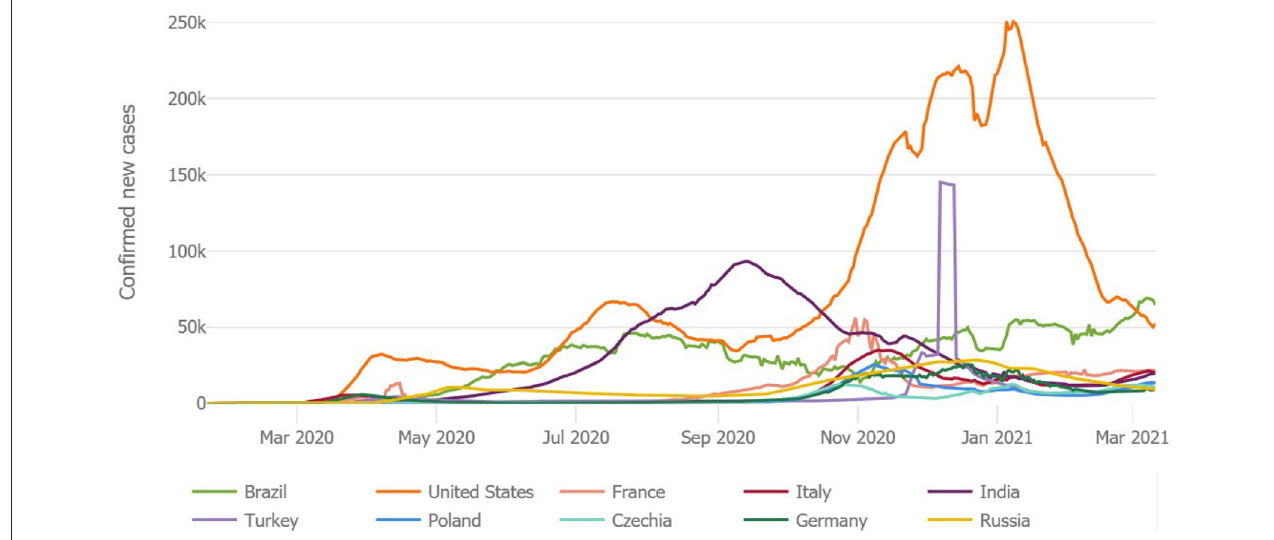
FIGURE 2 | COVID-19: new confirmed positive cases (7-Day Moving Average) by March 12, 2021. Source: WHO and JHU COVID-19